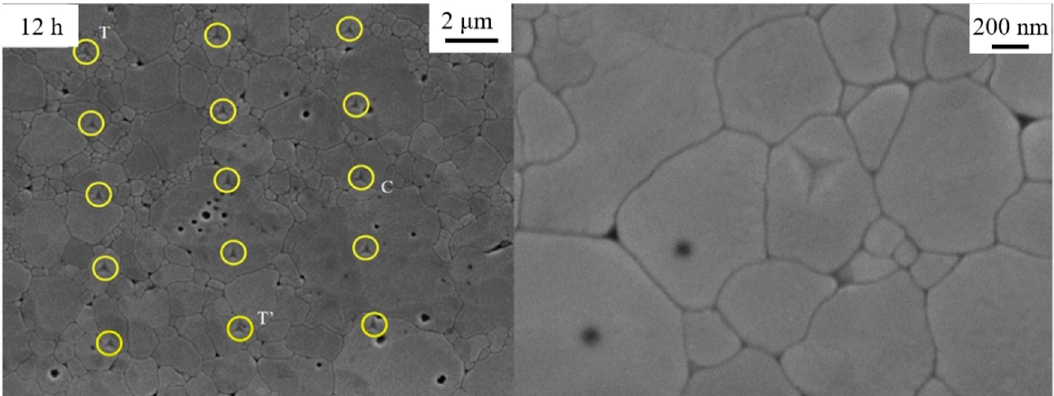
Figure 7. Nanoindentation of 8YSZ microstructure with annealing time 12 h.